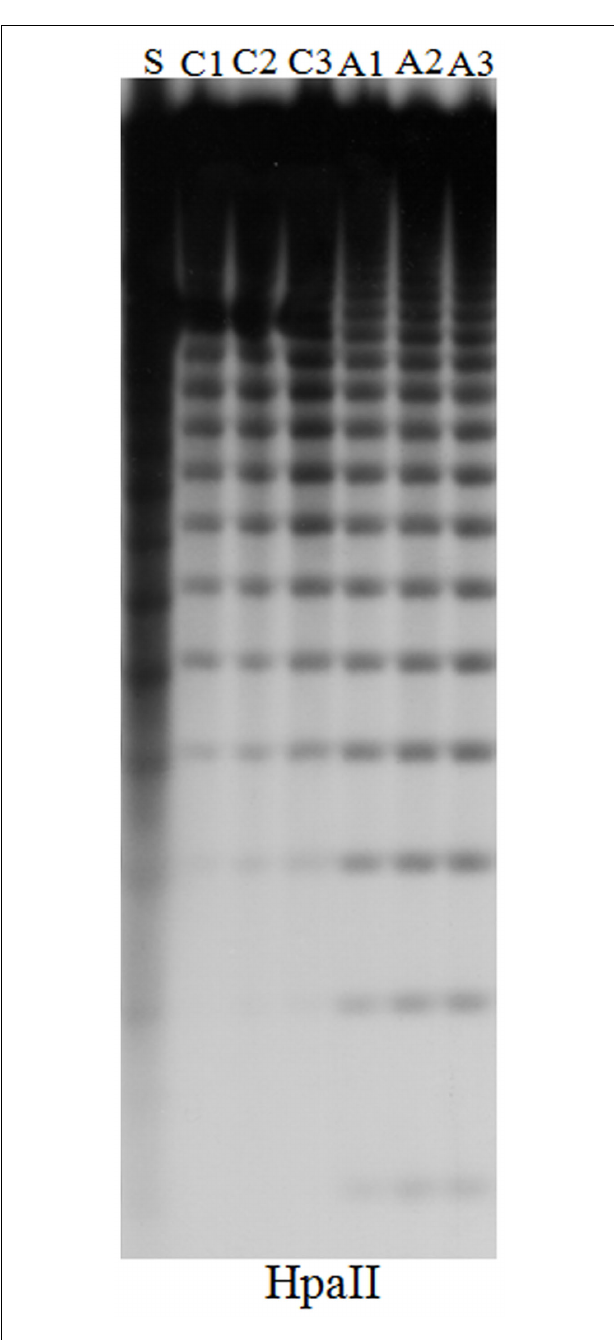
FIGUREA1 | DNA gel blot comparing DNA methylation at the 5S ribosomal DNA loci in untreated and 5-aza-2-deoxycytidine treated Hi-IIA × B tissue-cultured cell lines. The plant and callus DNA was digested with Hpa II to examine and CpG methylation respectively. An increase in number and intensity of low molecular weight bands in the Hpa II digested DNA indicates a decrease in DNA methylation. Hi-II A × B genomic DNA isolated from 14-day-old seedlings (S), from independent untreated control cultures (C1–C3), from independent 5-aza-2-deoxycytidine cultures (A1–A3).